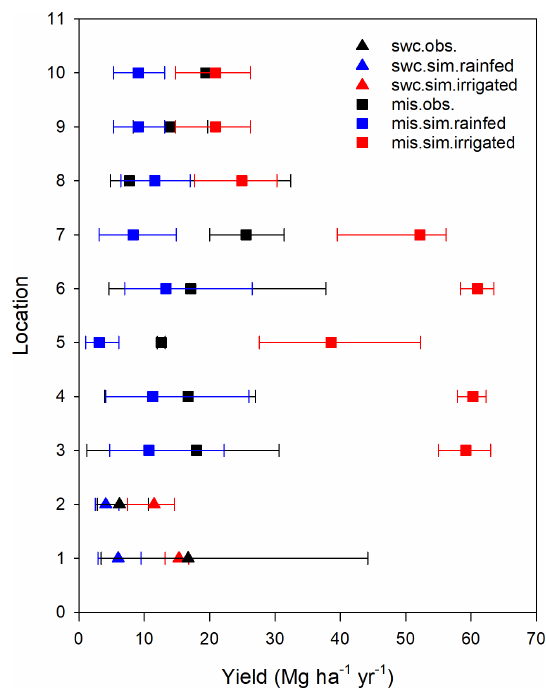
Figure 6. Site-specific performance (shown with increasing latitude from the bottom of the vertical axis) of the simulated yield (sim.) obtained using the enhanced H08 model compared with observed yields (obs.) for Miscanthus (mis.) and switchgrass (swc.) under ir- rigated condition. The longitude and latitude of each location ID for Miscanthus and switchgrass are given in Table S3. Obs. indi- cates the observed mean yield. The black error bar represents the range of the observed minimum and maximum yield. The red or blue error bar represents the range of the simulated minimum and maximum